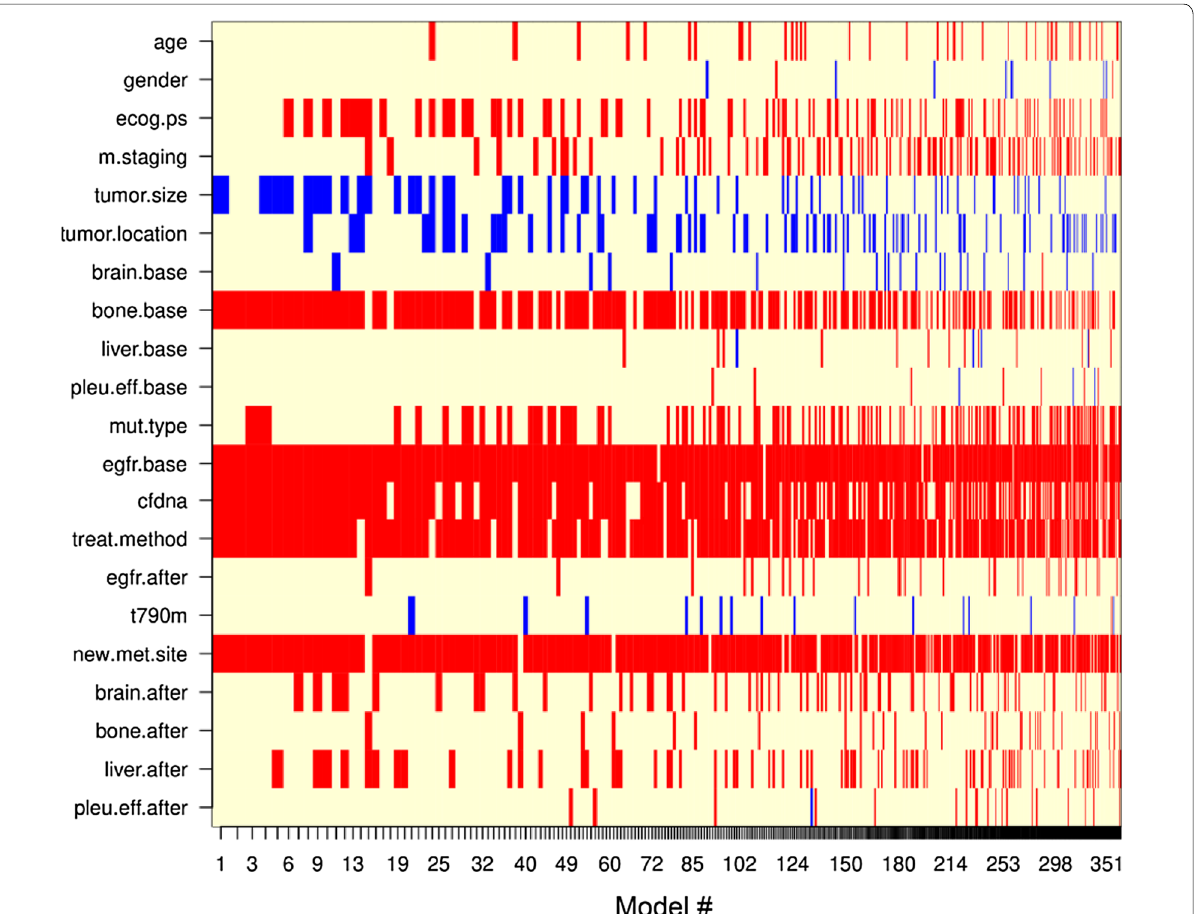
Fig. 8 The possibility that factors appear in prognostic models for OS by the Bayesian Model Averaging method. Bone metastasis at baseline (bone. base: 68.1%); EGFR plasma at baseline (egfr.base: 99.7%); cfDNA (cfdna: 73.4%); treatment method (treat.method: 83.5%); and new metastasis (new. met.site: 93.2%) factors present in most